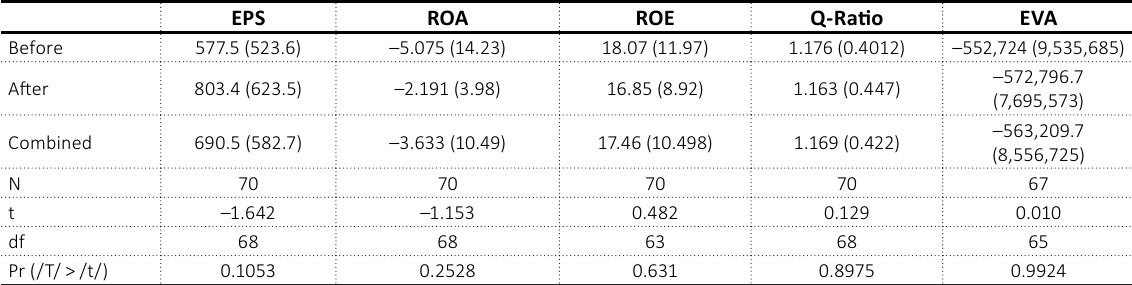
Table 4. Descriptive statistics of the banks’ performance before and after integrated